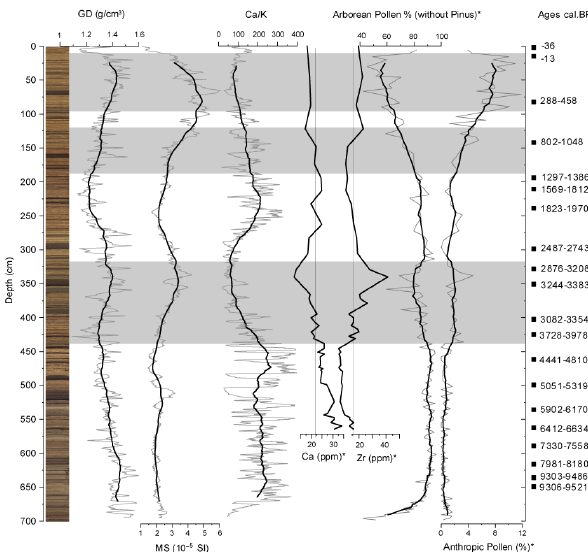
Fig. 6. Geophysical and geochemical proxies from the entire master core LL08-1, with calibrated radiocarbon ages. *Pollen analyses, Zr and Ca ICP-AES concentration measurements have been made on background sedimentation only. The Ca/K ratio is calculated from XRF measurements from the entire master core, as well as Gamma Density (GD) and Magnetic Susceptibility (MS) data. Grey bands show the main phases of sedimentological and vegetation covers change and marked by anthropic pollen indicator